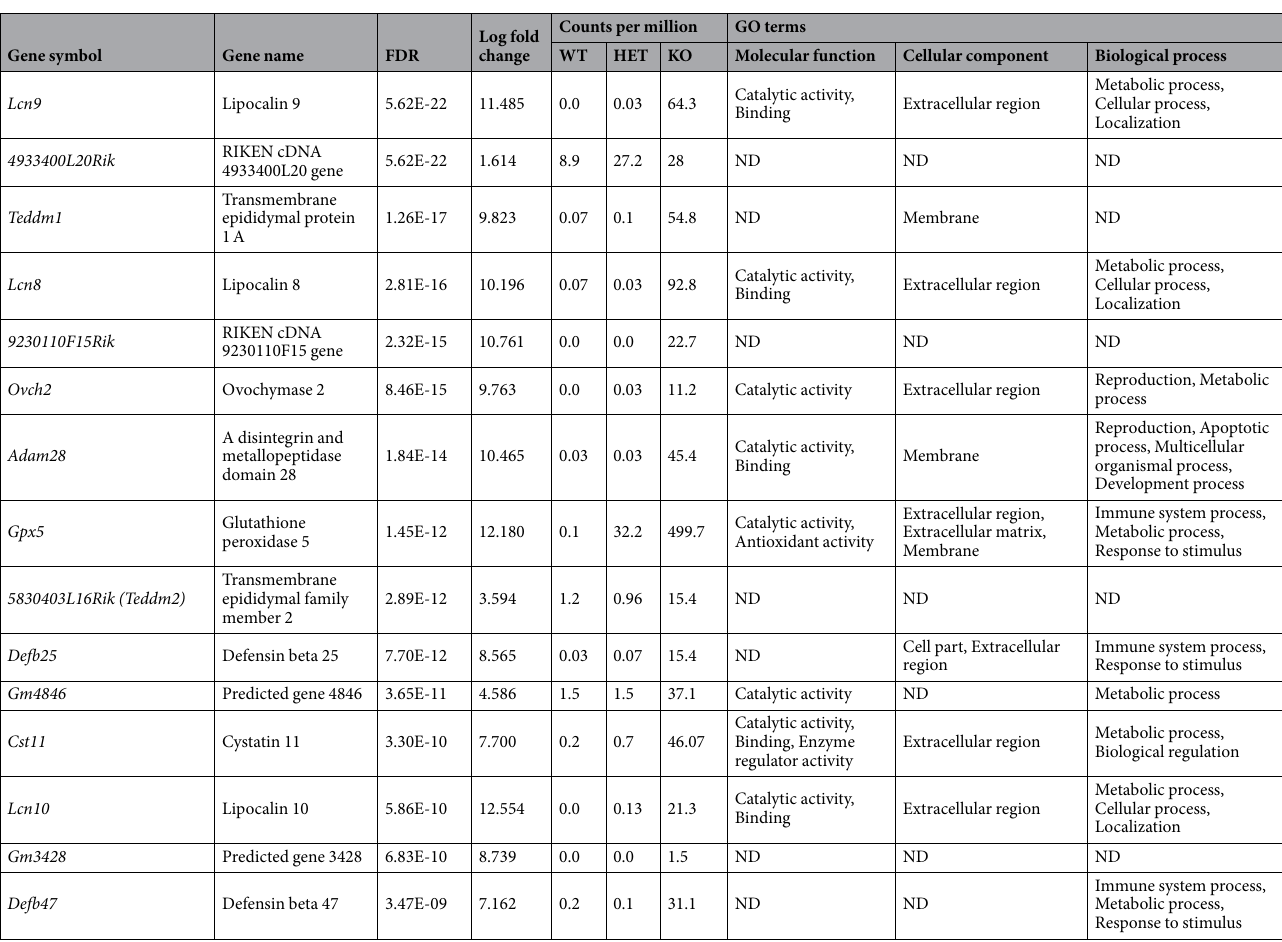
Table 1. Top-15 upregulated genes in the testes of PLAG1 - deficient mice. FDR, false-discovery rate; GO, gene ontology; HET, heterozygote; KO, knock-out; ND, not determined; WT,